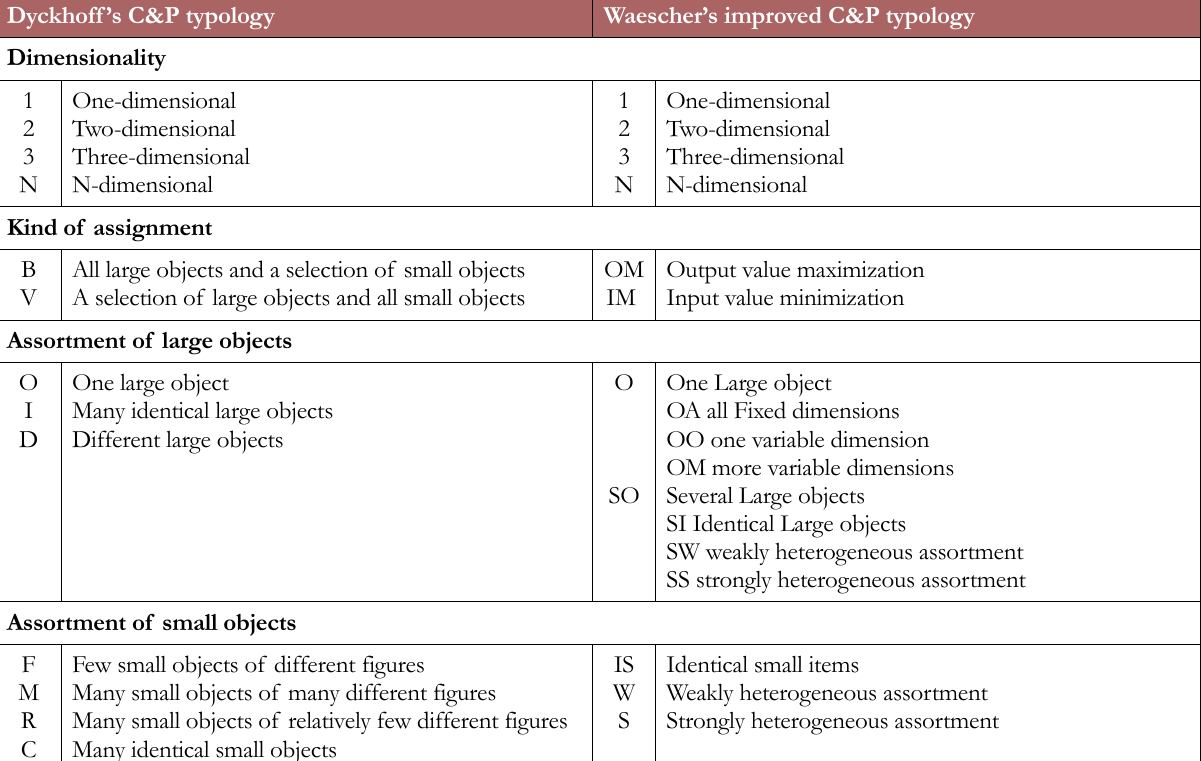
Table 1. Dyckhoff’s (1990) and Waescher’s (2007) typologies for C&P